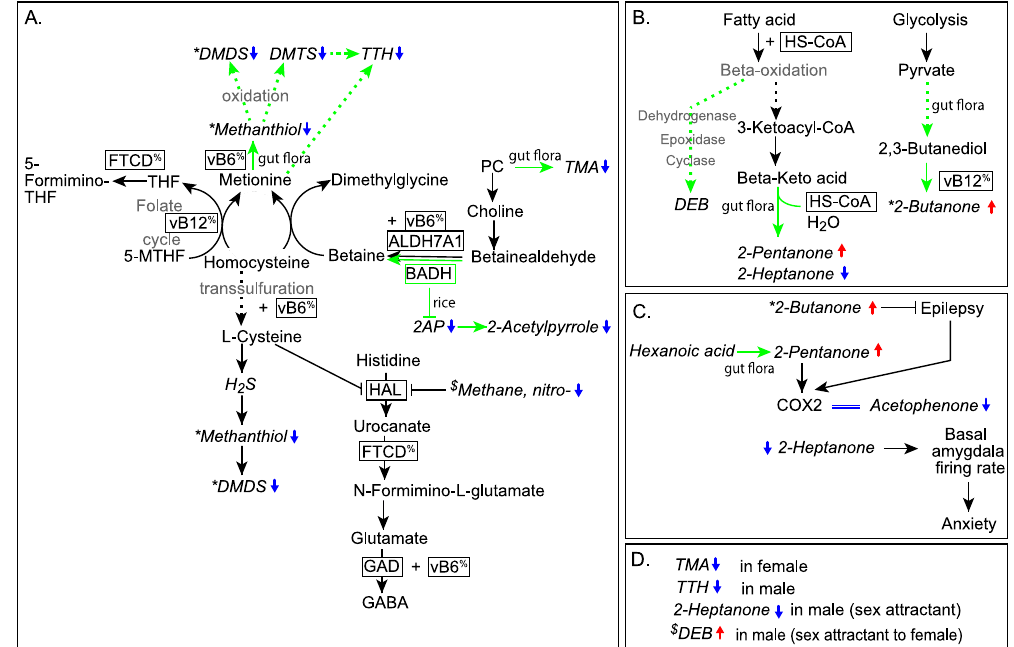
Figure 5. Metabolic networks ( A , B ) and representative physiological systems (C and D) containing the VOCs associated to kindled seizures. Transsulfation 30,32,35 , methionine-homocystaine cycle 38,39,61 , and histidine degradation 42,43 ( A ); fatty acid beta-oxidation networks and glycolysis 28,29,45,46 ( B ); epilepsy and anxiety 49,51,52,54 ( C ); and pheromones 34,50,56 ( D ). Abbreviations: 2-acetyl-pyrroline, 2AP; 5-formiminotetrahydrofolate, 5-formimino-THF; 5-methyltetrahydrofolate, 5-MTHF, aldehyde dehydrogenase 7 family member A1, ALDHTA1; betaine aldehyde dehydrogenase, BADH; cytochrome C oxidase subunit II, COX-2; 3,4-dehydro- exo -brevicomin, DEB; disulfide, dimethyl, DSDM; dimethyl trisulfide, DMTS; formimidoyltransferase cyclodeaminase, FTCD; gamma-aminobutyric acid, GABA; glutamate decarboxylase, GAD; hydrogen sulfide, H 2 S; histidine ammonia-lyase, HAL; phosphatidylcholine, PC; trimethylamine, TMA; 2,3,5-trithiahexane, TTH; vitamin B6, vB6. The percentage sign, %, indicates that FTCD and vB6C have bifunctional activities. Enzymes and coenzymes are enclosed in squares. Blue and red arrows show the differential VOCs (in italics) after kindled seizures; pathways described by green lines, arrows, and squares are derived from non-mammalian